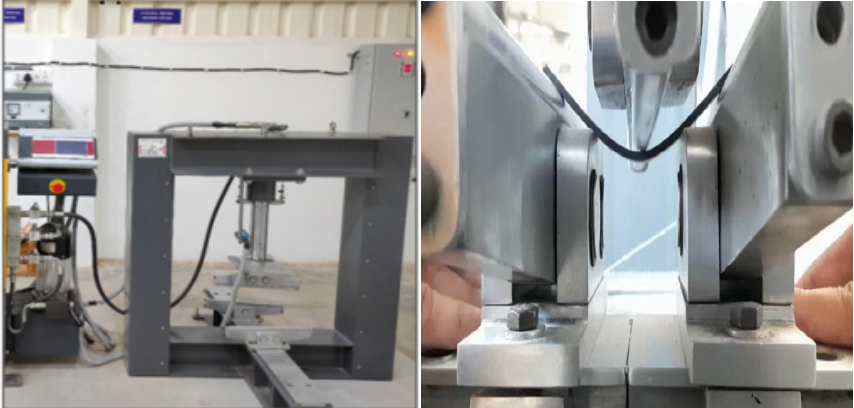
Figure 4. Flexural Test Setup.